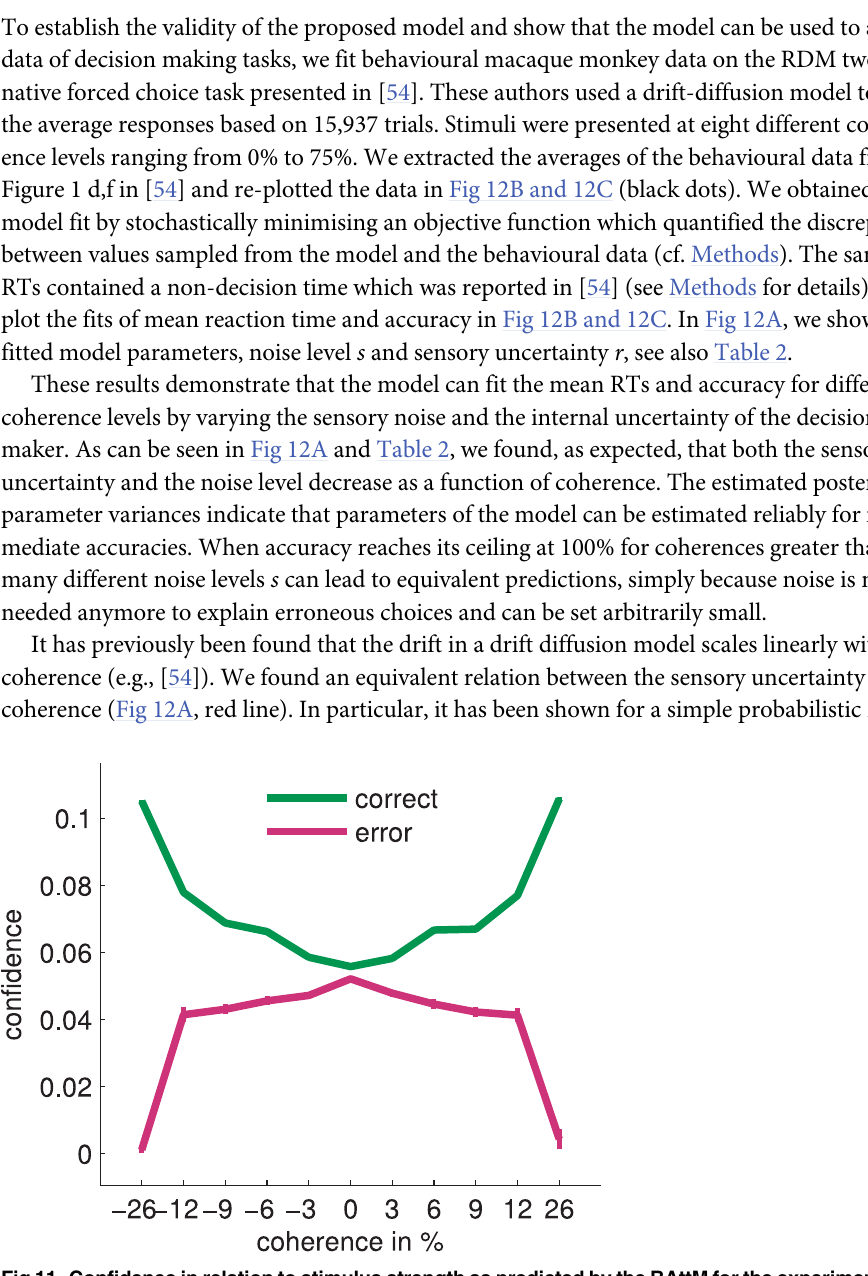
Fig 11. Confidence in relation to stimulus strength as predicted by the BAttM for the experiment of [54]. These confidence values result from continuing accumulation of evidence for 100ms after the internal threshold was crossed but before a corresponding motor response was completed (cf. [35]). Negative coherences: left motion stimulus, positive coherences: right motion stimulus. For each coherence level we simulated 2,500 trials (5,000 for 0% coherence) using the BAttM. Shown are mean confidence values and their standard errors. Parameters were those listed in Table 2 with q =